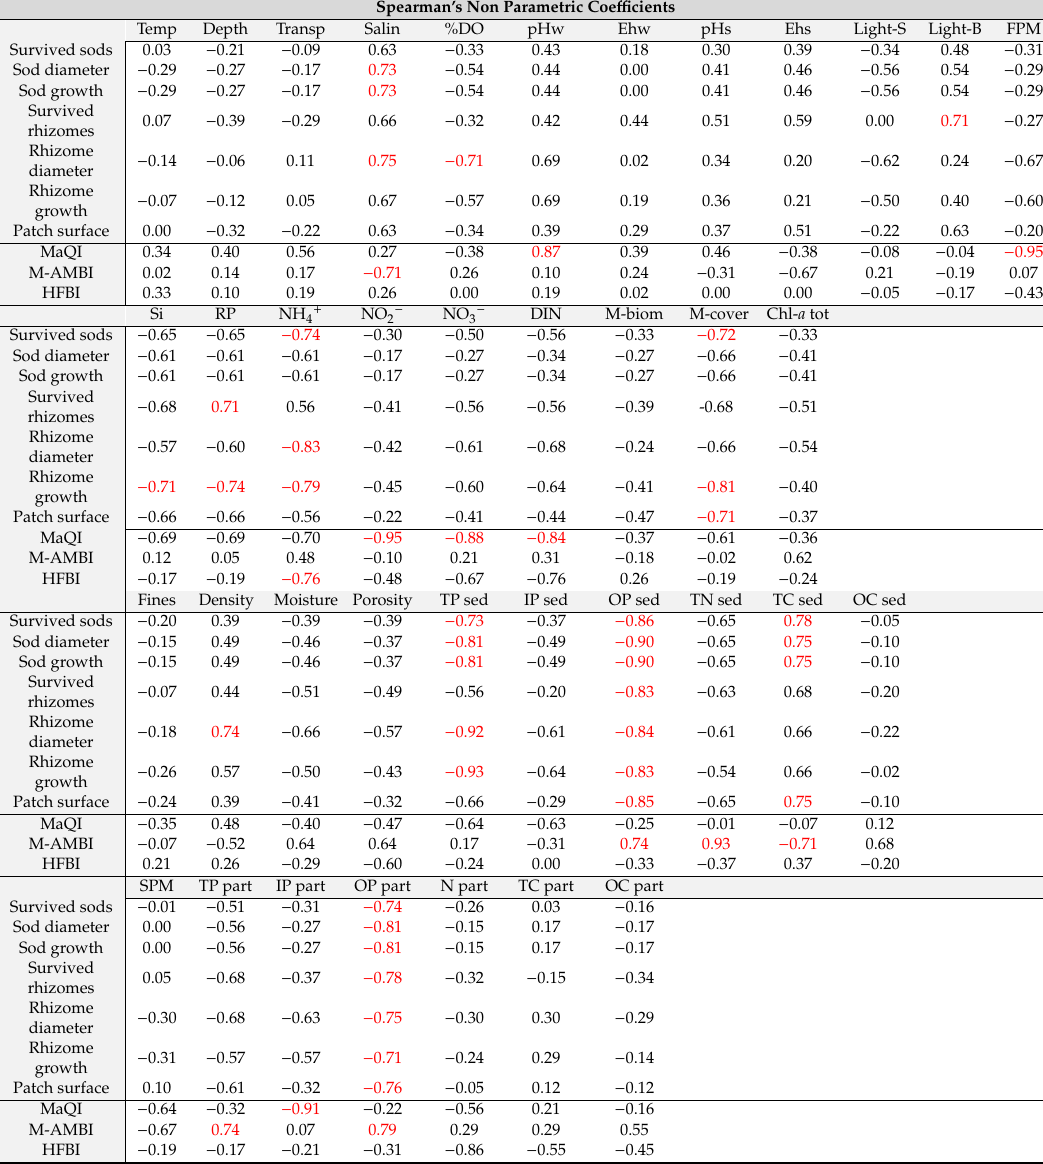
Table 1. Spearman’s non-parametric coe ffi cients between sod / rhizome variables and physico-chemical parameters and nutrient concentrations in the water column and surface sediments. Significant values ( p < 0.05) are in red. Legend:, Temp = water temperature, Transp = water transparency, Salin = salinity, %DO = percentage of dissolved oxygen, Eh = redox potential, w = water, s = sediment, Light-S = light at a depth of − 5 cm, Light-B = light at bottom, FPM = filtered particulate matter, Si = silicates, RP = reactive phosphorus, NH 4 + = ammonium, NO 2 − = nitrites, NO 3 − = nitrates, DIN = dissolved inorganic nitrogen, M-biom = macroalgal biomass, M-cover = macroalgal cover, Chl -a tot = total Chlorophyll- a , TP = total phosphorus, IP = inorganic phosphorus, OP = organic phosphorus, TN = total nitrogen, TC = total